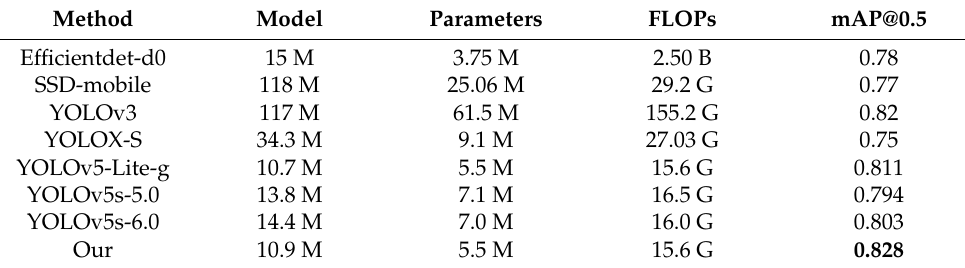
Table 5. Performance comparison on VOC2007+2012 dataset.